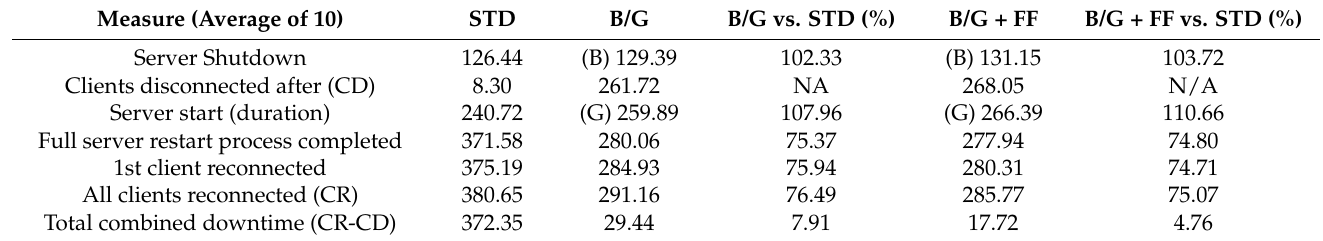
Table 1. ERP level—server node restart (regular case, all measurements in seconds, STD—standard approach, B—blue, G—green, FF—feature